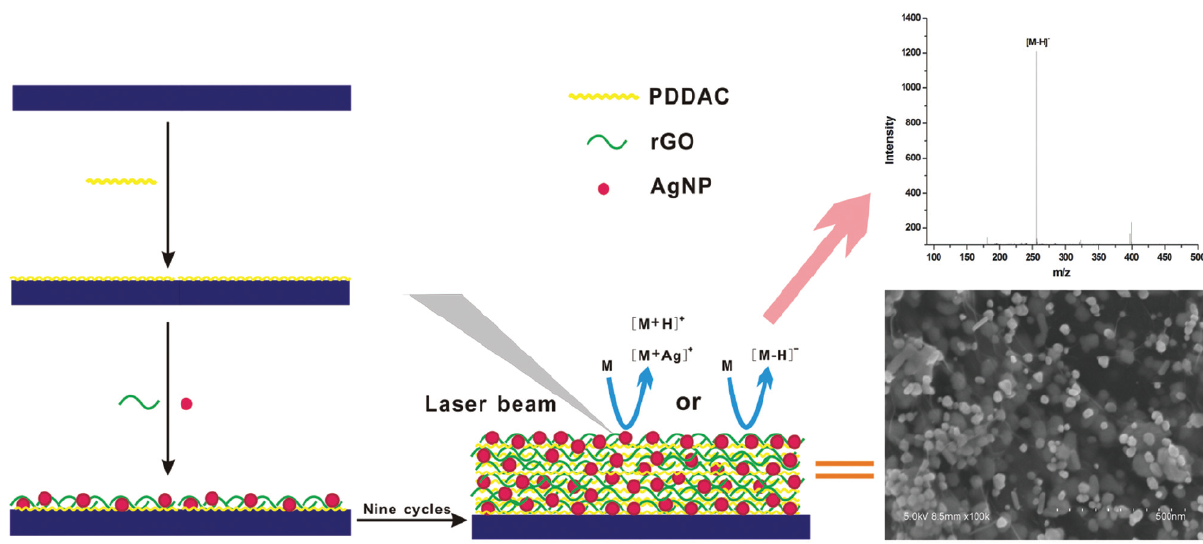
Figure 7. Preparation process and structure of Ag NPs/RGO nanohybrid films, and their application to LDI-TOF-MS analysis of small molecules. Reproduced from ref. [86] with permission from The Royal Society of Chemistry.